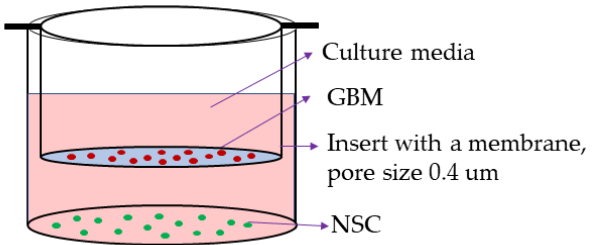
Figure 4. Coculture setup. A single well representation from a 6-well plate. GBM cells were cultured in the insert while the NSCs were positioned at the bottom of the well outside of the insert. Cells were unable to pass through the 0.4 µm pore size of the cell insert membrane, only letting EVs and signaling molecules pass through.